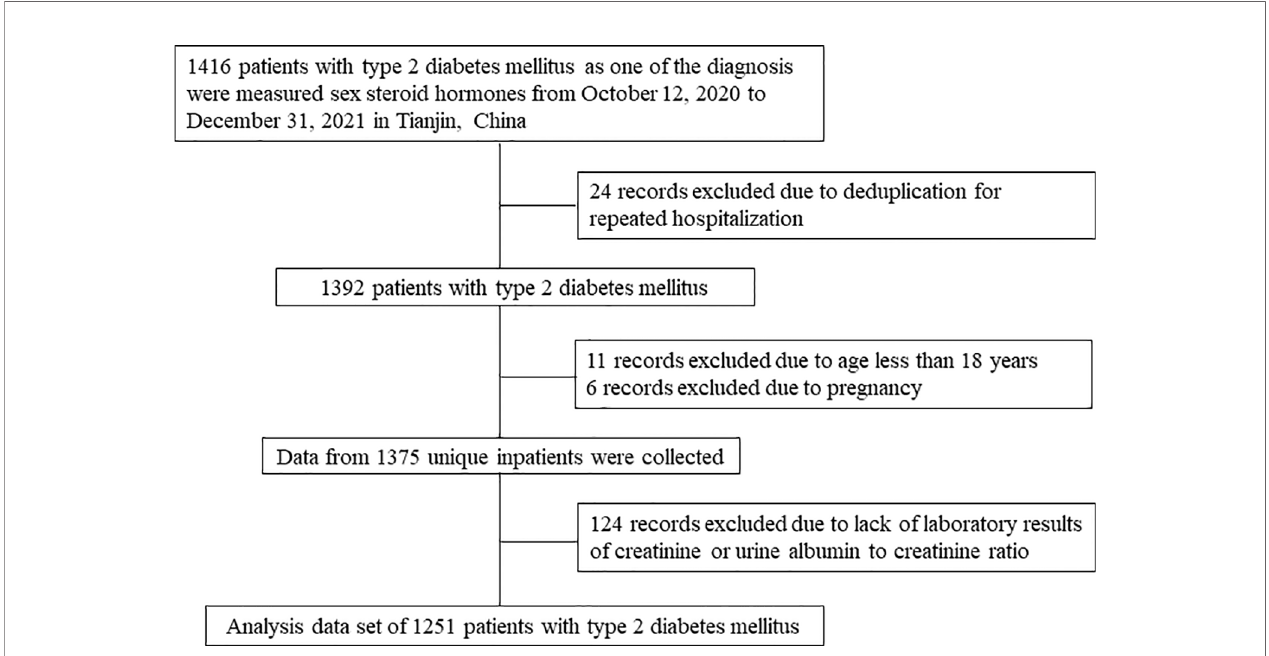
FIGURE 1 | Flow chart of identi fi cation of study population. There were 1251 patients with T2DM included in the fi nal